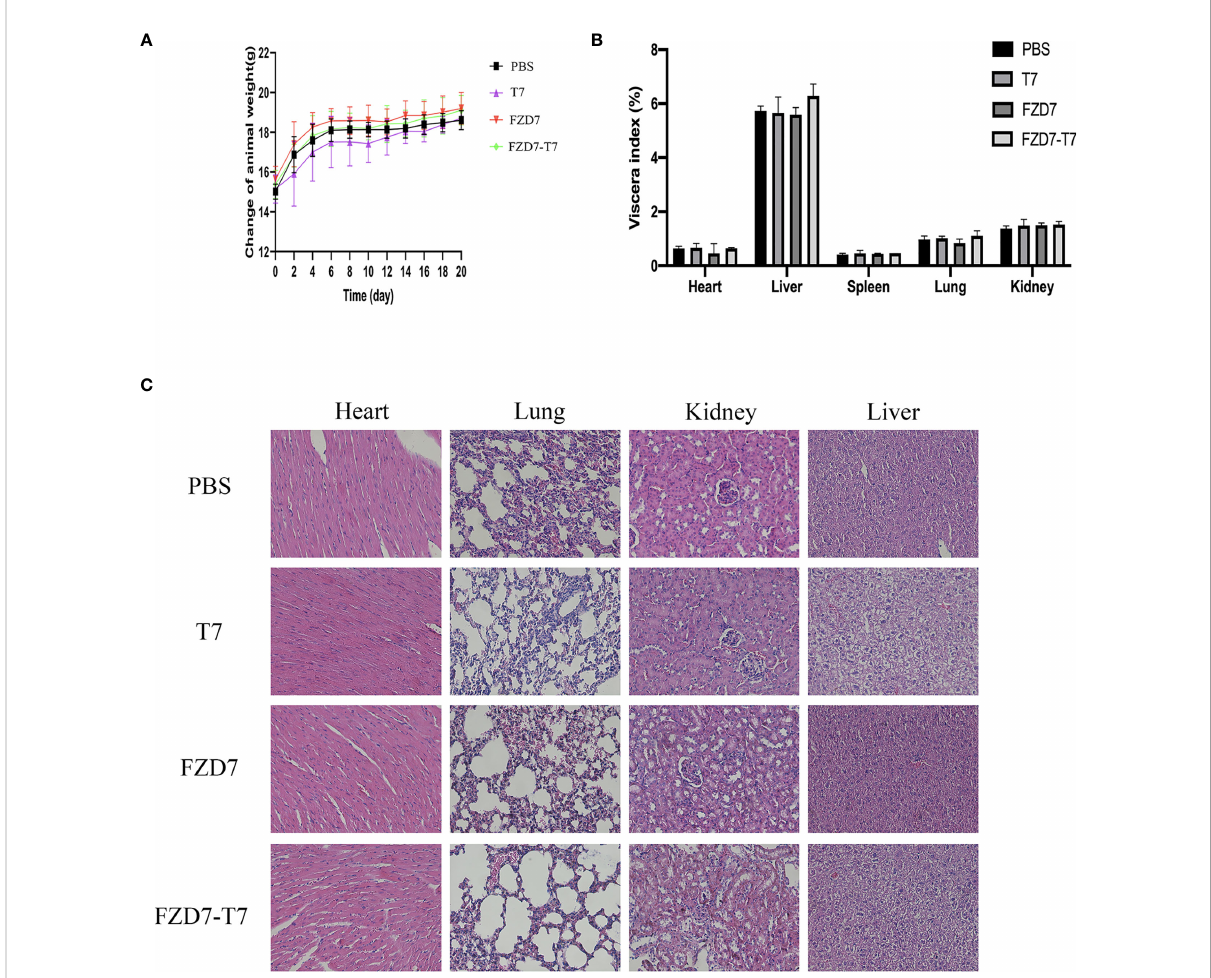
FIGURE 8 Toxicity studies. (A) Bodyweight curve of mice during immunization. (B) Viscera index of mice after immunization. (C) HE staining of mouse